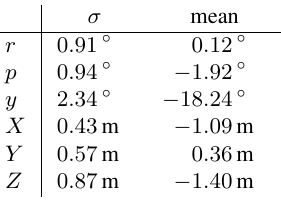
Table 2: Standard deviation σ and mean of the differences be- tween direct and indirect georeferencing.